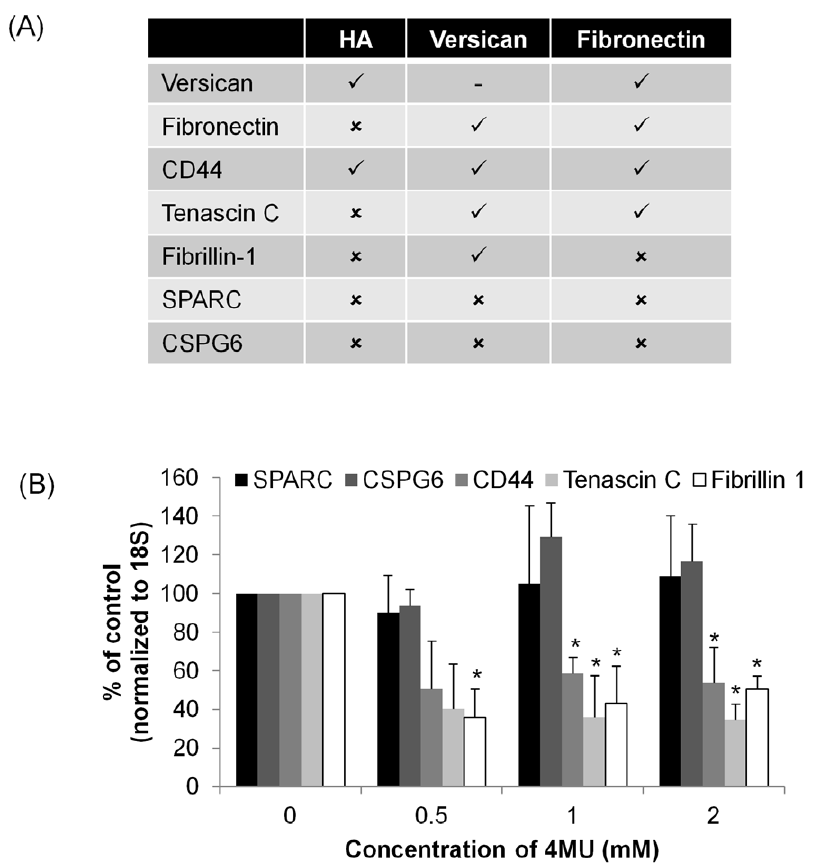
Figure 7. The effects of 4MU on mRNA levels of other ECM genes. (A) The table summarizes the previously identified binding interactions of HA, versican and fibronectin reported in the literature. (B) Quantitative RT-PCR of mRNA levels of CD44, tenascin C, fibrillin-1, CSPG6 and SPARC in TM cells treated with 0, 0.5, 1 and 2 mM 4MU for 36 hours. All mRNA levels were normalized to 18S RNA levels and presented as a percentage of the control. Error bars are the s.e.m. N=3, apart from CSPG6, where n=4. * P , 0.05 by one-way ANOVA.